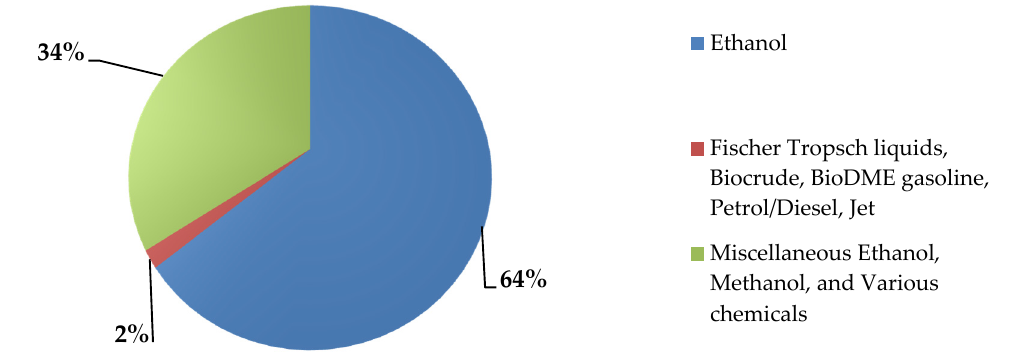
Figure 5. Advanced biofuels by fuel products—operational, 225.43 million gallons/year. Data adapted from [127].